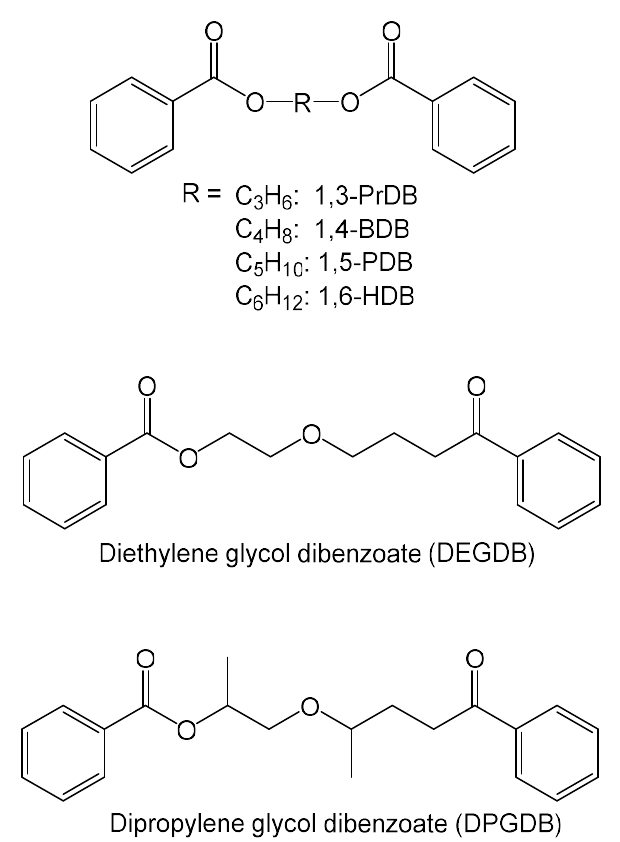
Figure 2. Chemical structures of the proposed diol dibenzoate plasticizers and two commercial dibenzoate plasticizers (diethylene glycol dibenzoate (DEGDB), dipropylene glycol dibenzoate (DPGDB)). Abbreviations: 1,3-PrDB is 1,3-propanediol dibenzoate; 1,4-BDB is 1,4-butanediol (DPGDB)). Abbreviations: 1,3-PrDB is 1,3-propanediol dibenzoate; 1,4-BDB is